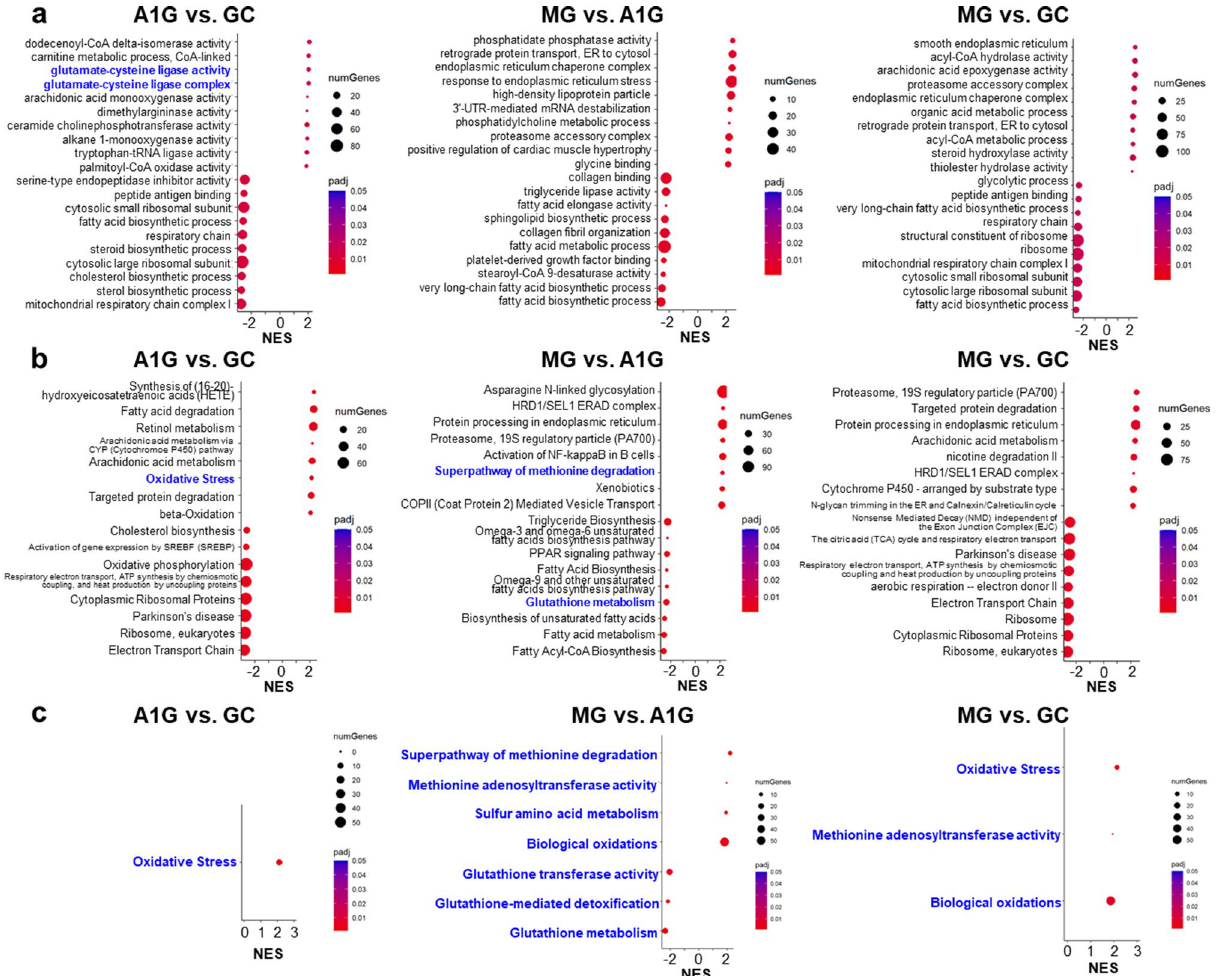
Figure 4.. Gene set enrichment analysis (GSEA) of differentially expressed genes in the livers after spaceflight. The normalized enrichment score (NES) of each term is plotted. GSEA of differentially expressed genes annotated to Gene Ontology (GO) ( a ), and Reactome, KEGG, WikiPathways, BIOCYC, and LIPID MAPS ( b ) in the livers compared in between GC, A1G, and MG mice. The top 10 pathways with the highest and lowest NES values were shown each. ( c ) GSEA results about pathways related to oxidative stress, sulfur metabolism, or glutathione metabolism. The dot color, the adjusted p-value of enrichment; NumGenes, the leading-edge genes that drive the enrichment of each category. Pathways colored blue are related to oxidative stress, sulfur metabolism, or glutathione metabolism. Analysis was conducted in R 31 , using the R packages GOseq 38 and fgsea 39